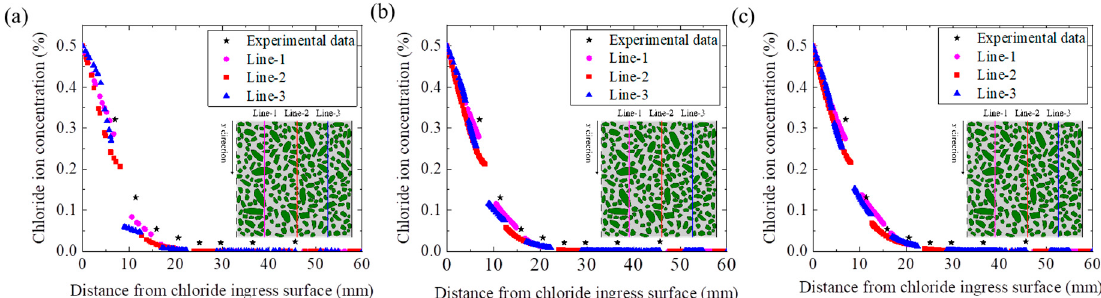
Figure 5. The profile of chloride concentration distribution ( a ) without ITZ, ( b ) the ITZ thickness = 50 μ m, ( c ) the ITZ thickness = 100 μ m, respectively. Table 2. Verifies the model parameters.